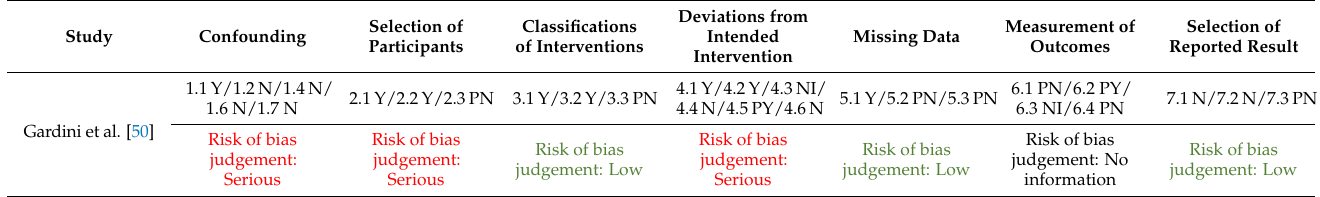
Table A2. Risk of bias assessment for non-randomized studies according to ROBINS-I